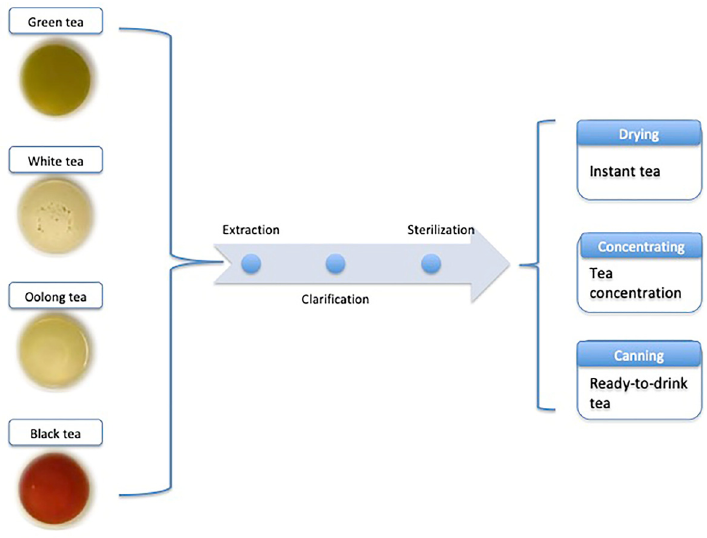
Figure 2. Processing of tea beverages.